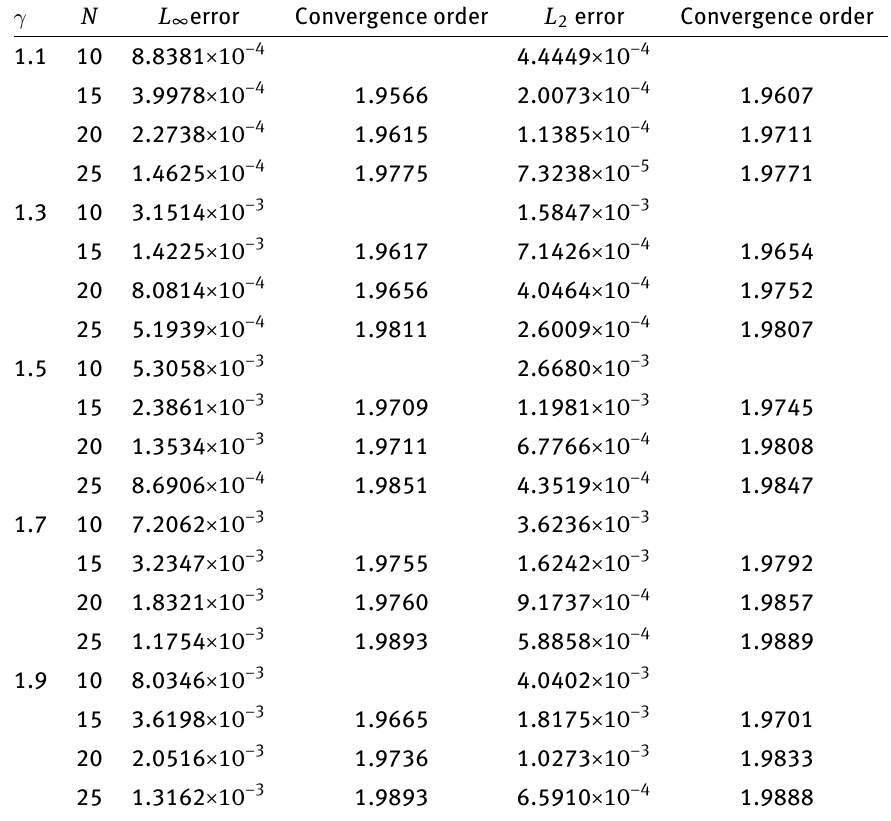
Table 7: The L ∞ , L 2 errors and temporal convergence orders for Example